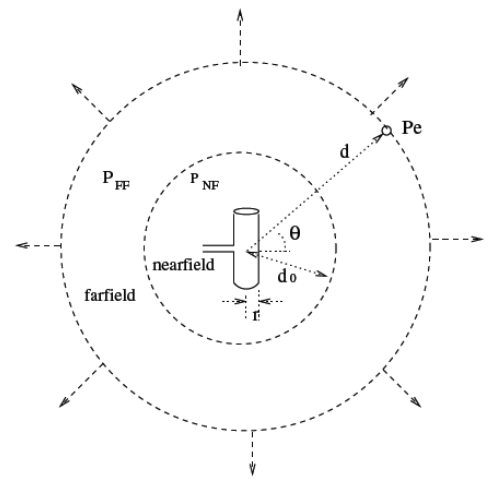
Figure 10. Field regions around a Hertzian